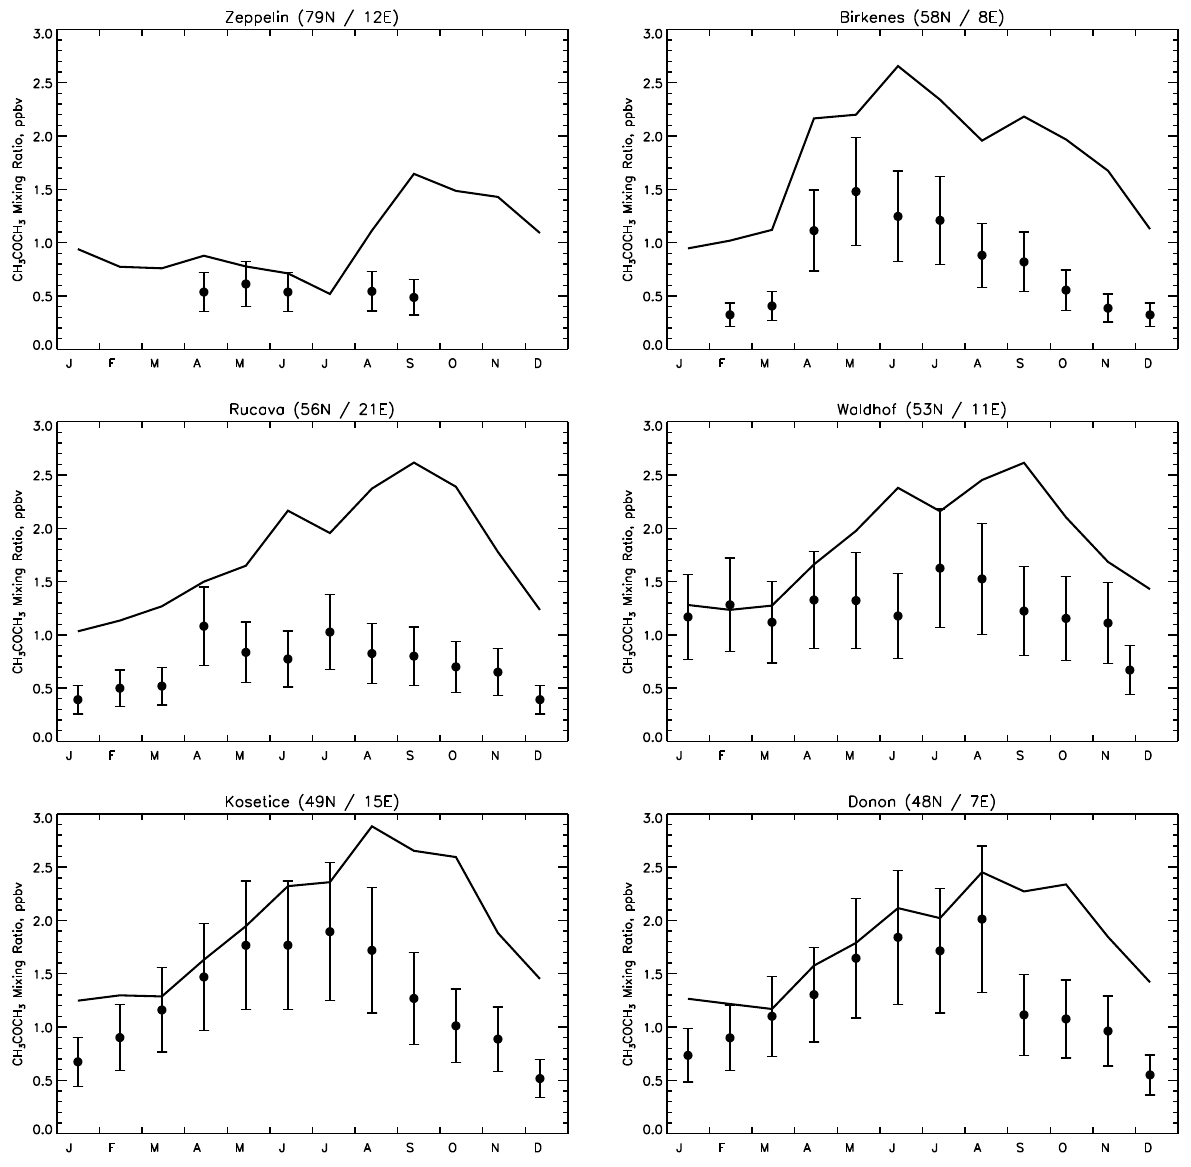
Fig. 8. Annual cycle of acetone vmr measured at surface level at 6 European stations (Solberg et al., 1996) (dots for averages and vertical bars for standard deviation), and climatological annual cycle computed by LMDz-INCA